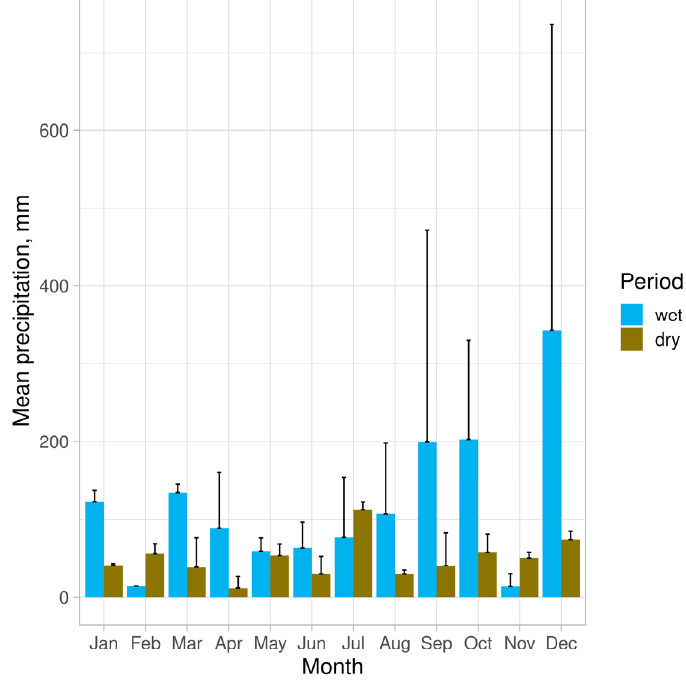
Figure 1. Average monthly precipitation during the two-year wet (1993–1994) and two-year drought (2009–2010) periods in the study area.